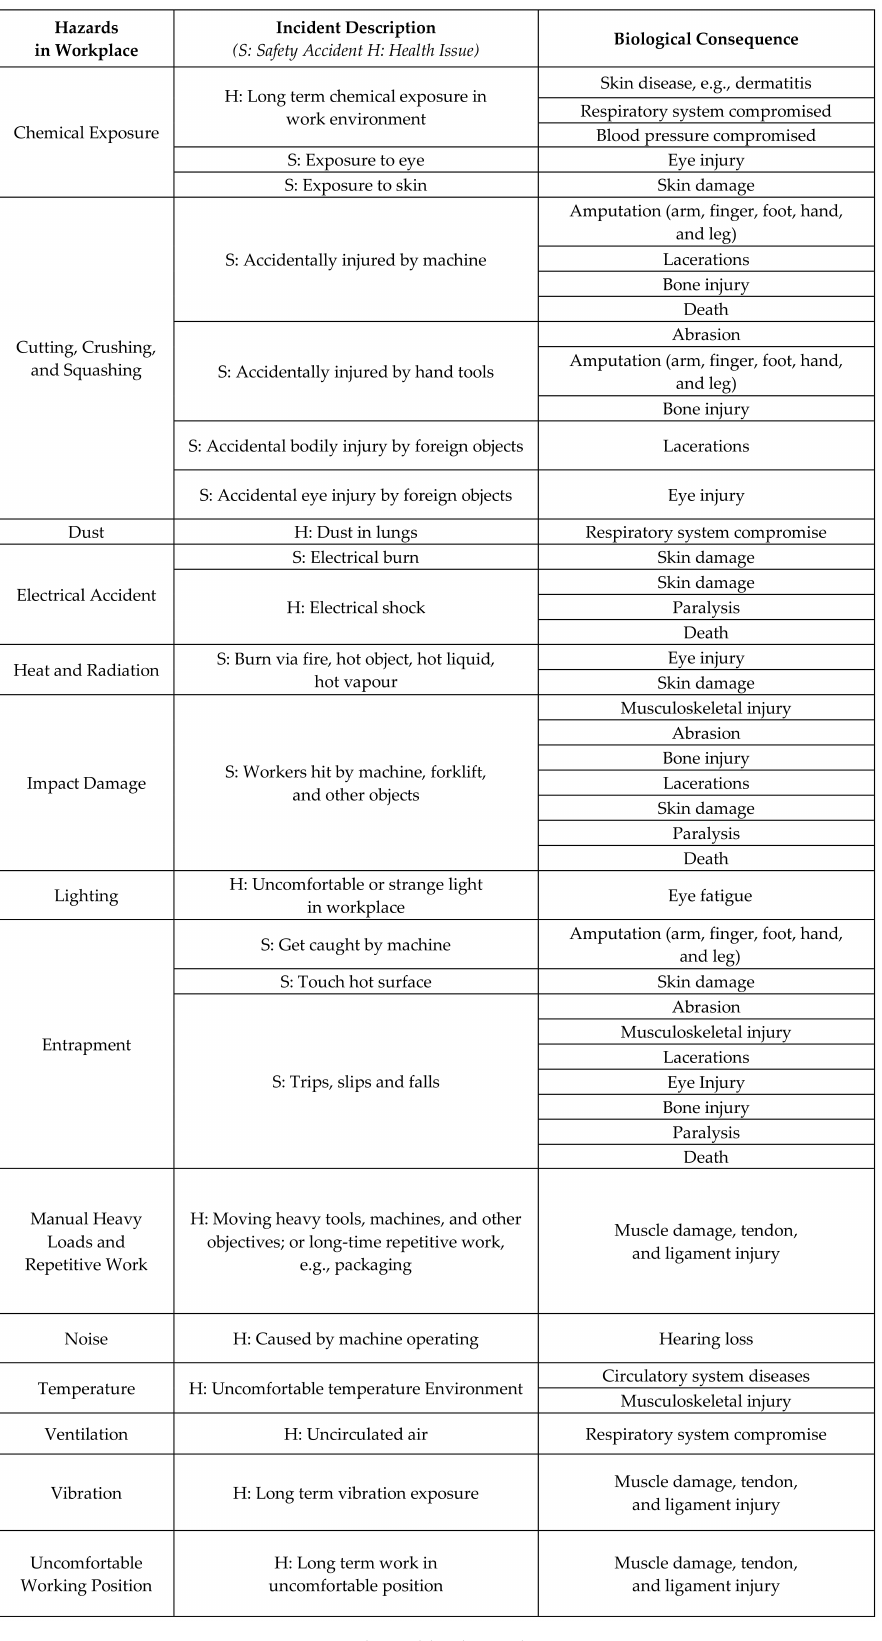
Figure 5. Hazards and biological